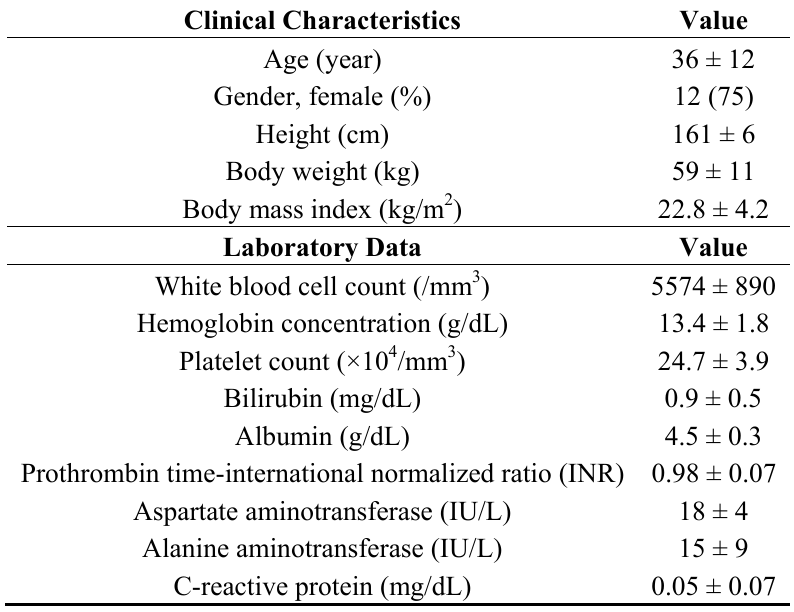
Table 1. Clinical characteristics of 16 healthy liver donors on admission.